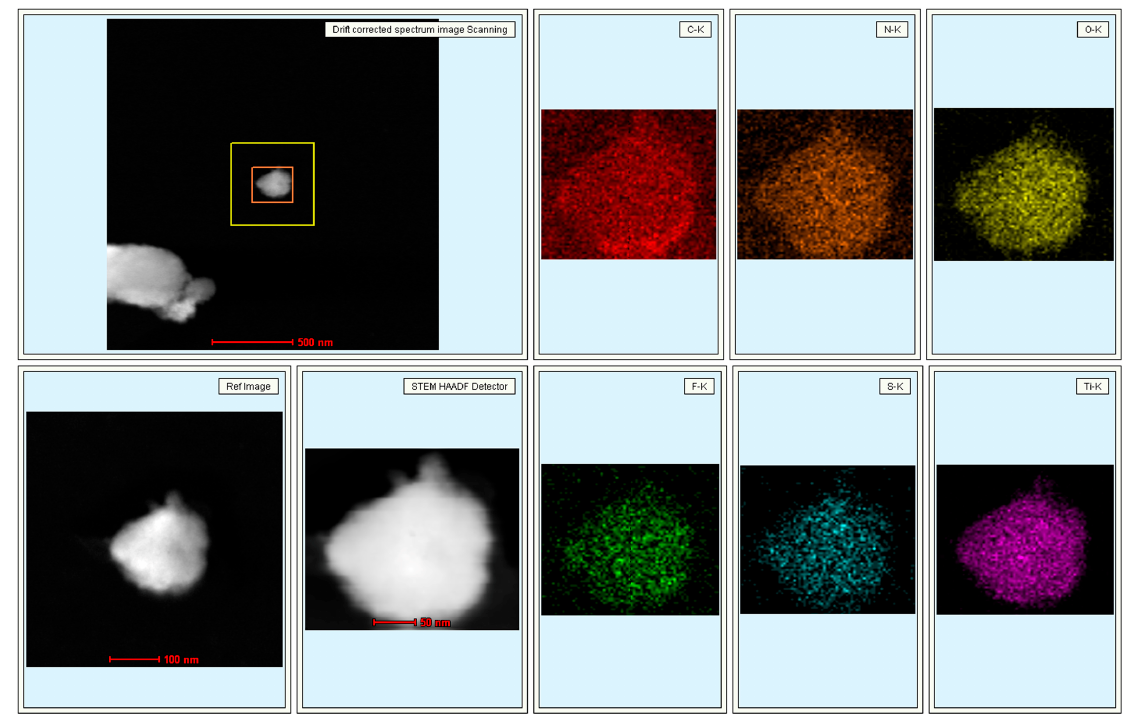
Figure 4. TEM images with elemental mapping scans of C/N/O/F/S/Ti in MXene-SO3H/RhB composite film.